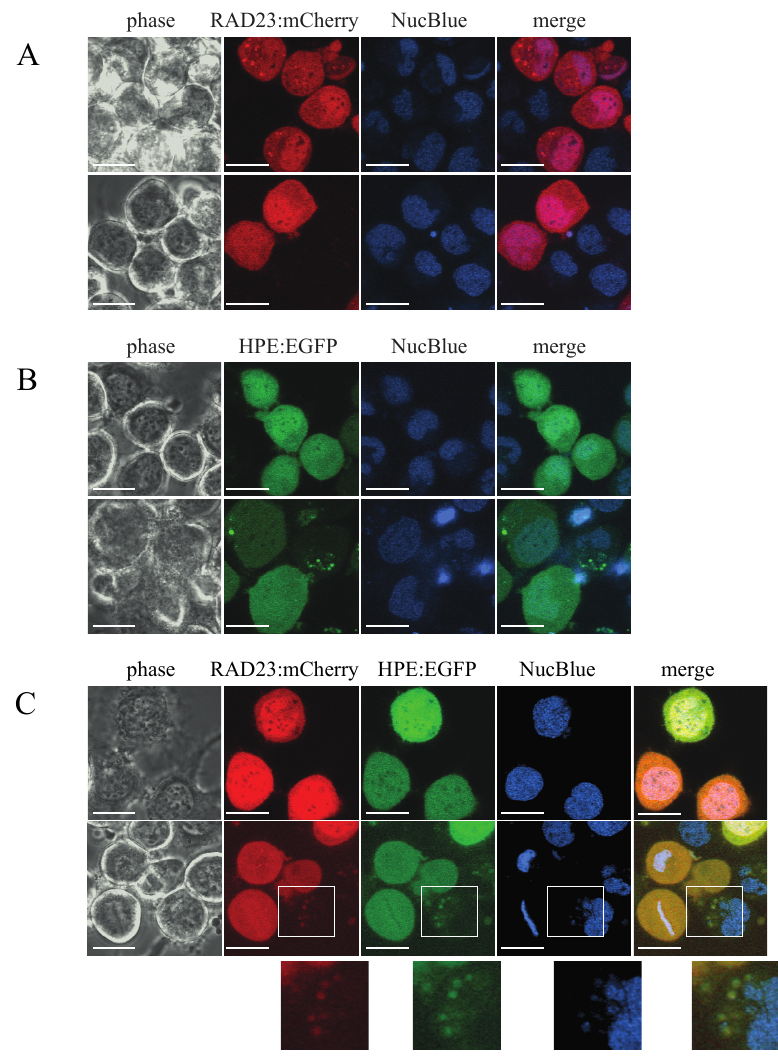
Figure 4. ( A ) BcRAD23e and HPE1B colocalize in the nucleus and cytosol of cultured Tni insect cells. ( A ) Transient expression of a red fluorescent chimera of BcRAD23 (RAD23:mCherry). ( B ) Transient expression of a green fluorescent chimera of HPE1B (HPE:EGFP). ( C ) Colocalization of the RAD23:mCherry and HPE:EGFP fluorescent signals in the cytosol and nucleus. Colocalized signals in discrete punctae were also observed in some cells (lower panel insets). Images were taken 48 h post-transfection with NucBlue used as a counterstain for the nucleus. Scale bar = 20 µm .